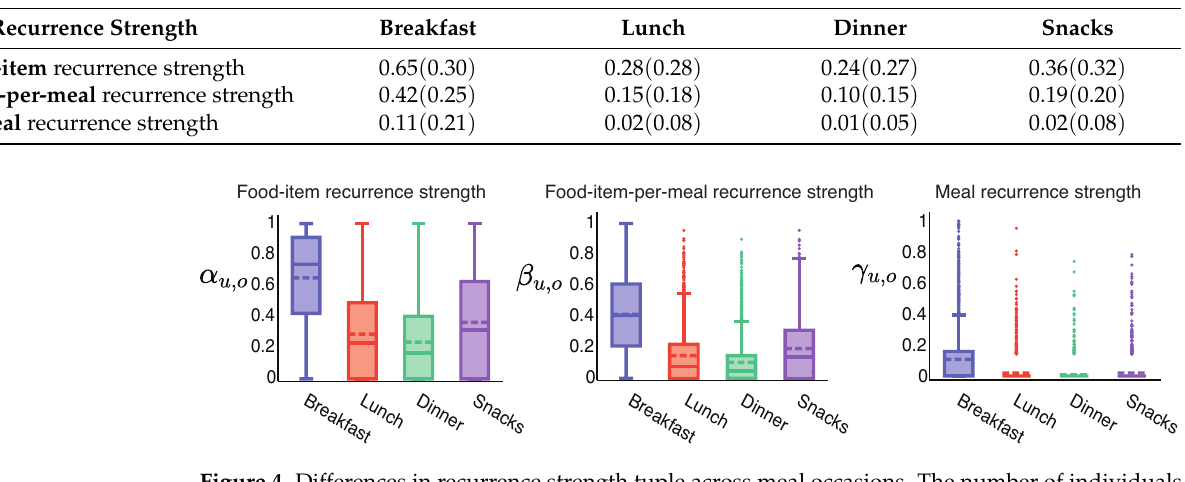
Figure 4. Differences in recurrence strength tuple across meal occasions. The number of individuals in each box plot is